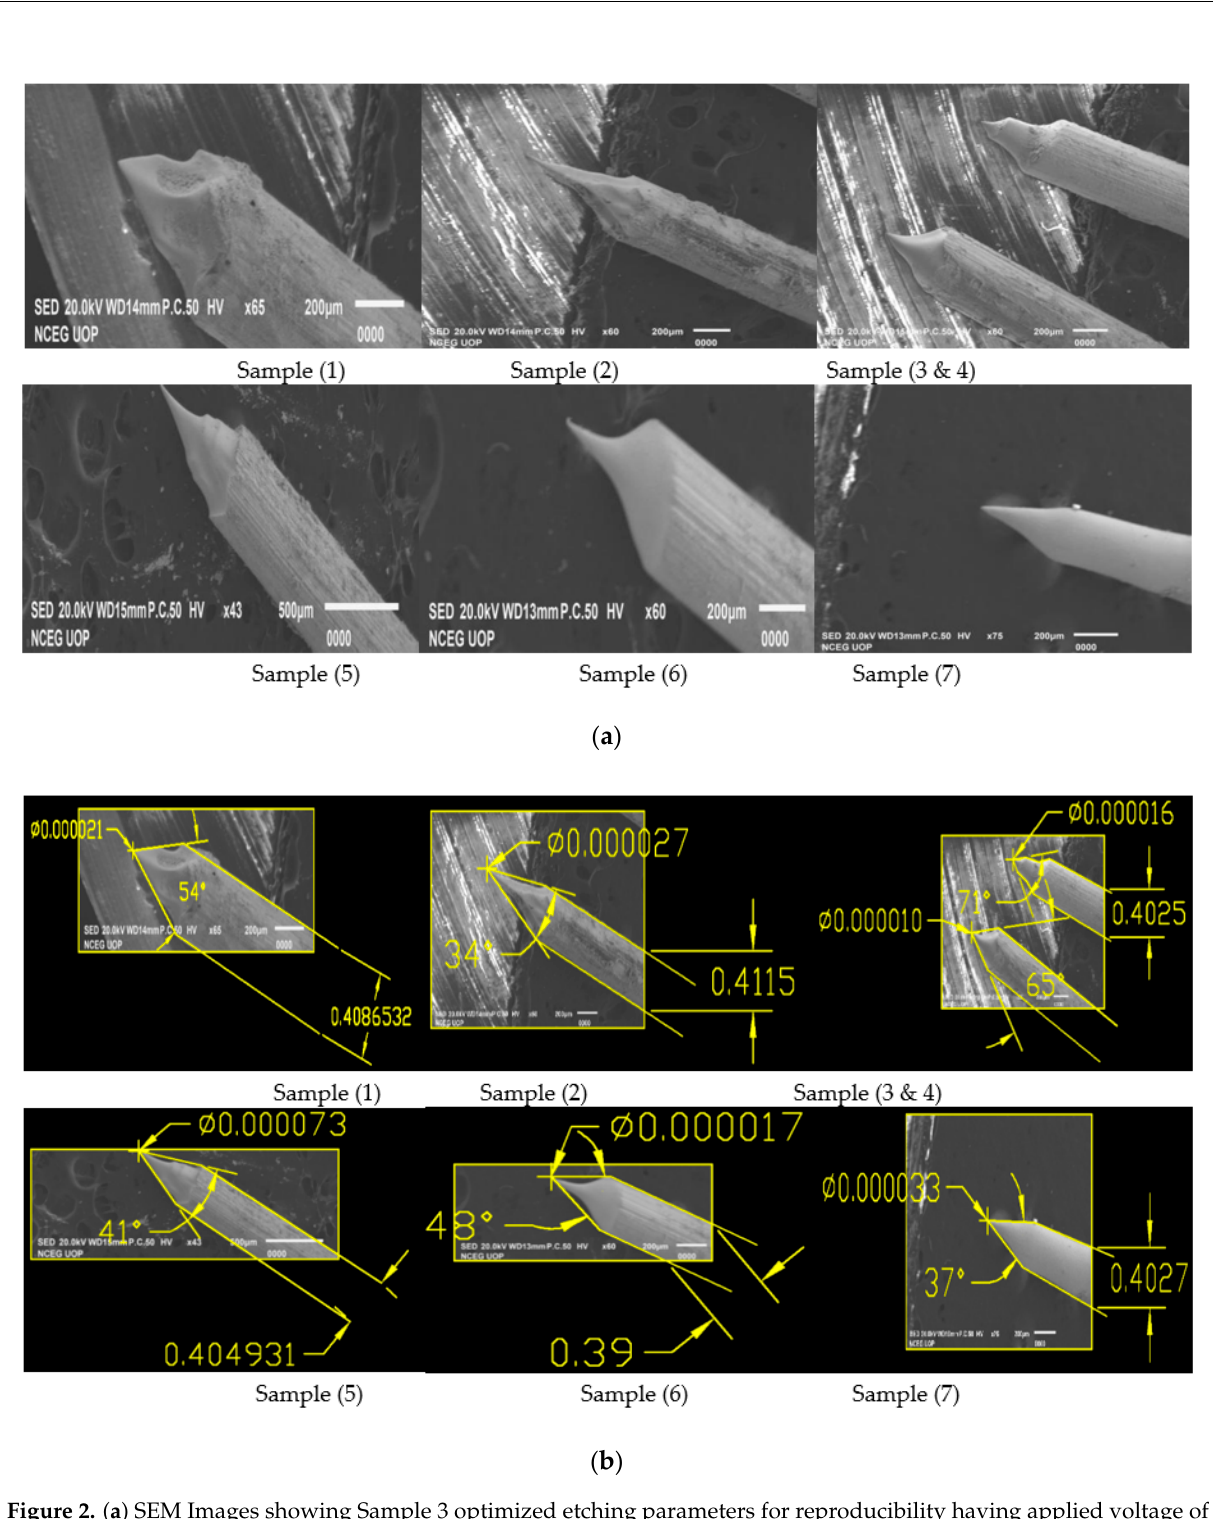
Figure 2. ( a ) SEM Images showing Sample 3 optimized etching parameters for reproducibility having applied voltage of 6.6 V in 2 M NaOH solution; ( b ) SEM Images of tungsten tips showing Sample 3 cone angle and tip diameter measured using AutoCAD Software.